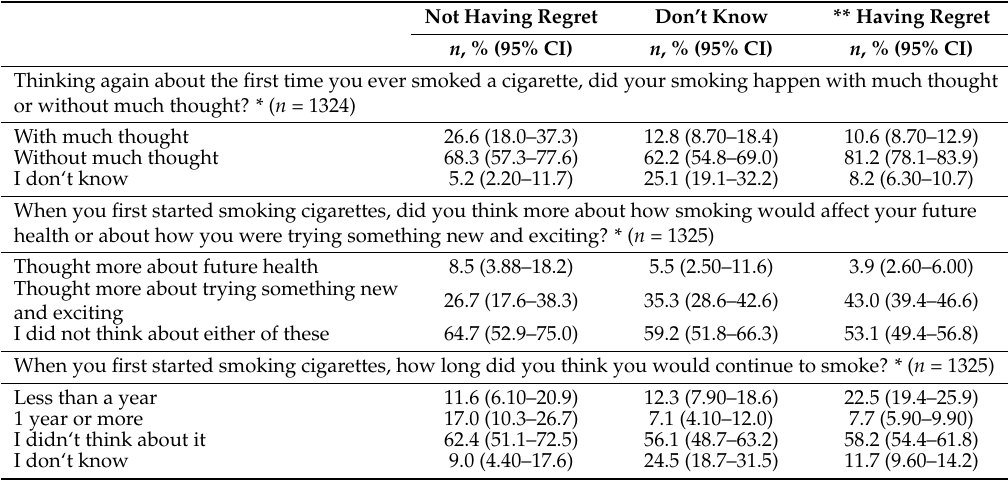
Table 4. Smoker’s beliefs and intentions during smoking initiation by regret status.